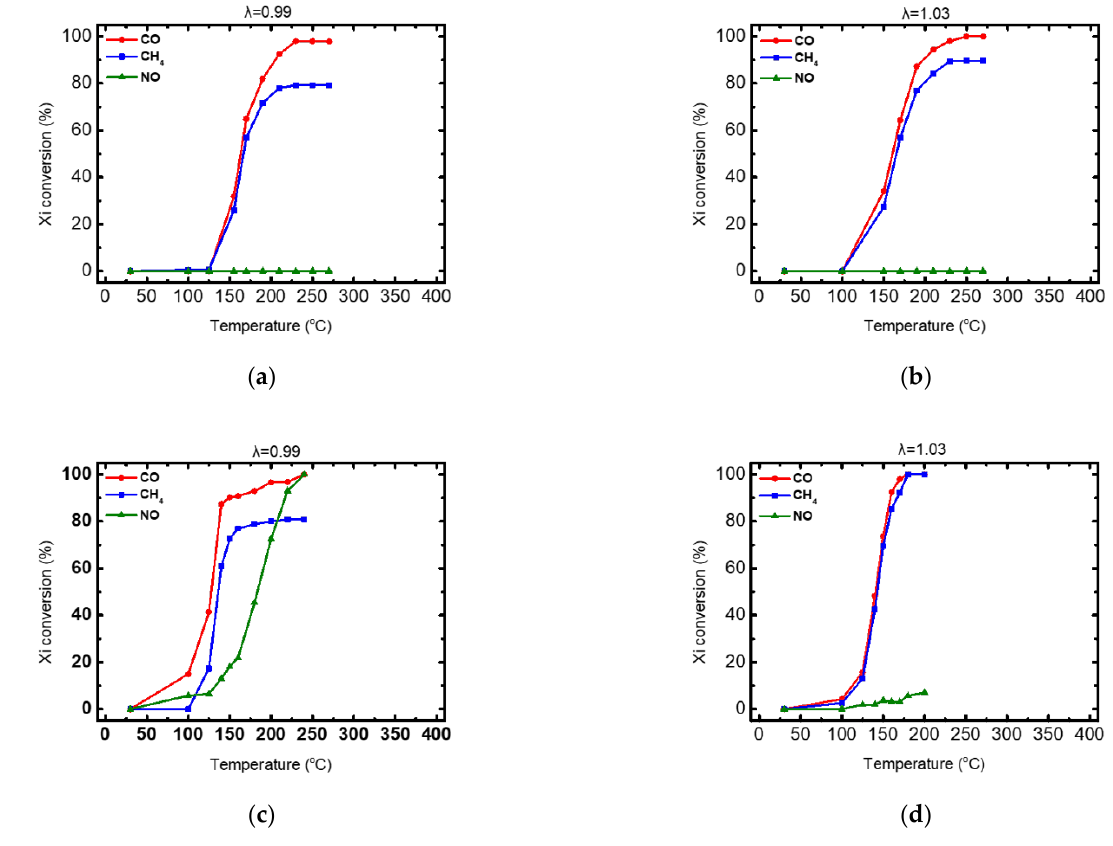
Figure 16. Light-off curves for the conversion of CO, CH 4 and NO: ( a ) copper monometallic catalyst powder under rich-burn conditions (λ = 0.99); ( b ) copper monometallic catalyst powder under lean-burn conditions (λ = 1.03); ( c ) PROM2 trimetallic catalyst powder under rich-burn conditions (λ = 0.99); ( d ) PROM2 trimetallic catalyst powder under lean-burn conditions (λ = 1.03).